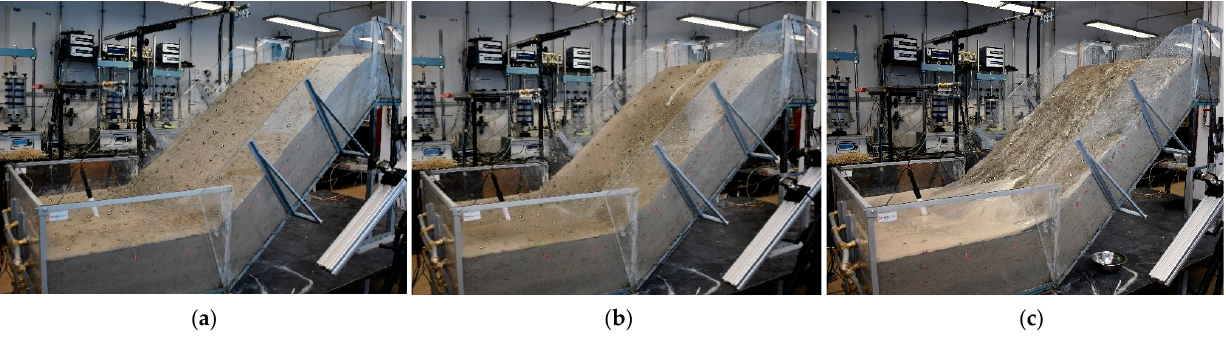
Figure 11. The SK15 slope model considered in Example 2 at the start of the test ( a ); 18 min ( b ); and 159 min after the start of the test ( c ).